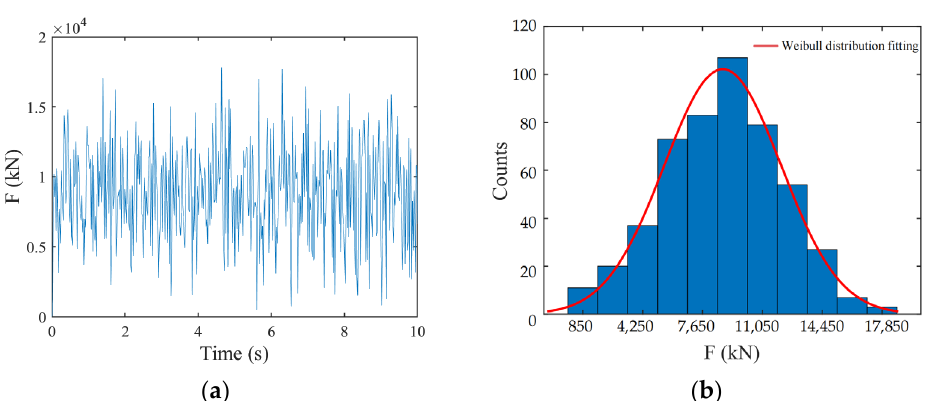
Figure 2. Trust and distribution characteristics of the cu tt erhead: ( a ) Curve of trust with time; ( b ) The distribution.